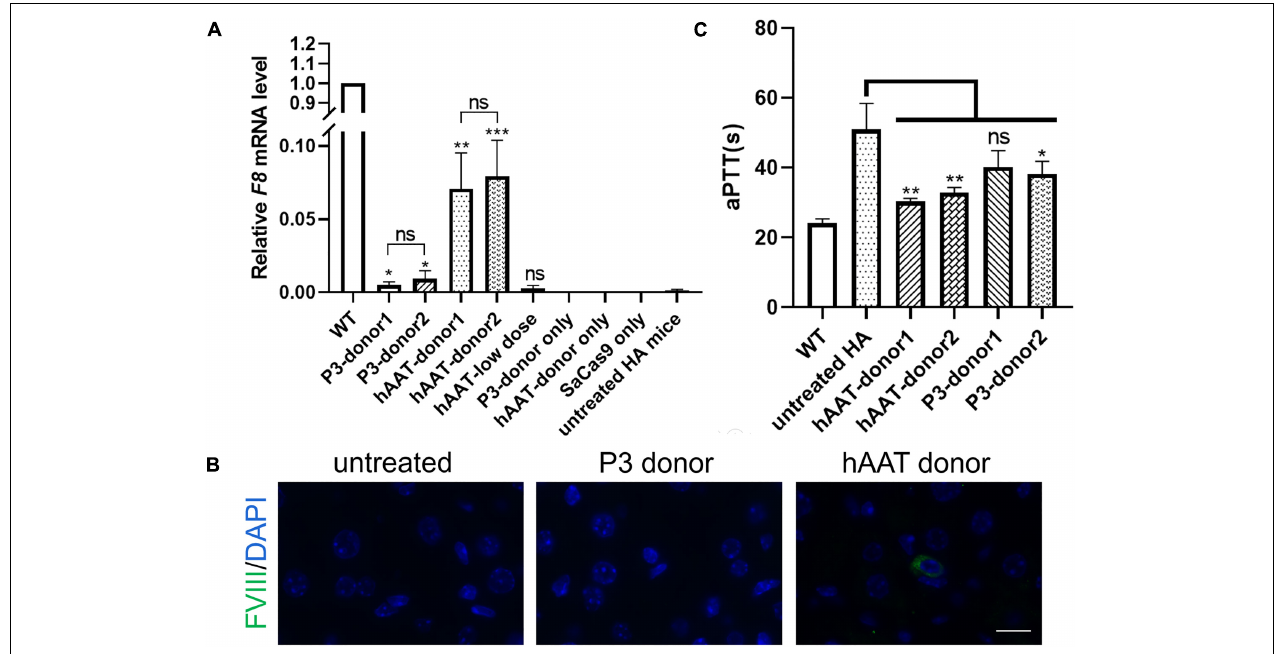
FIGURE 6 | F8 expression after targeted gene repair. (A) Expression levels of F8 mRNA in the hepatic tissue of indicated mice 1 month after AAV injection. The analysis was performed in triplicate. (B) Immunofluorescence staining of FVIII in liver sections of indicated mice. (C) Measurement of coagulation activity by testing the aPTT of the plasma collected from the indicated mice 1 month after AAV injection. ∗ P < 0.05, ∗∗ P < 0.01, ∗∗∗ P <